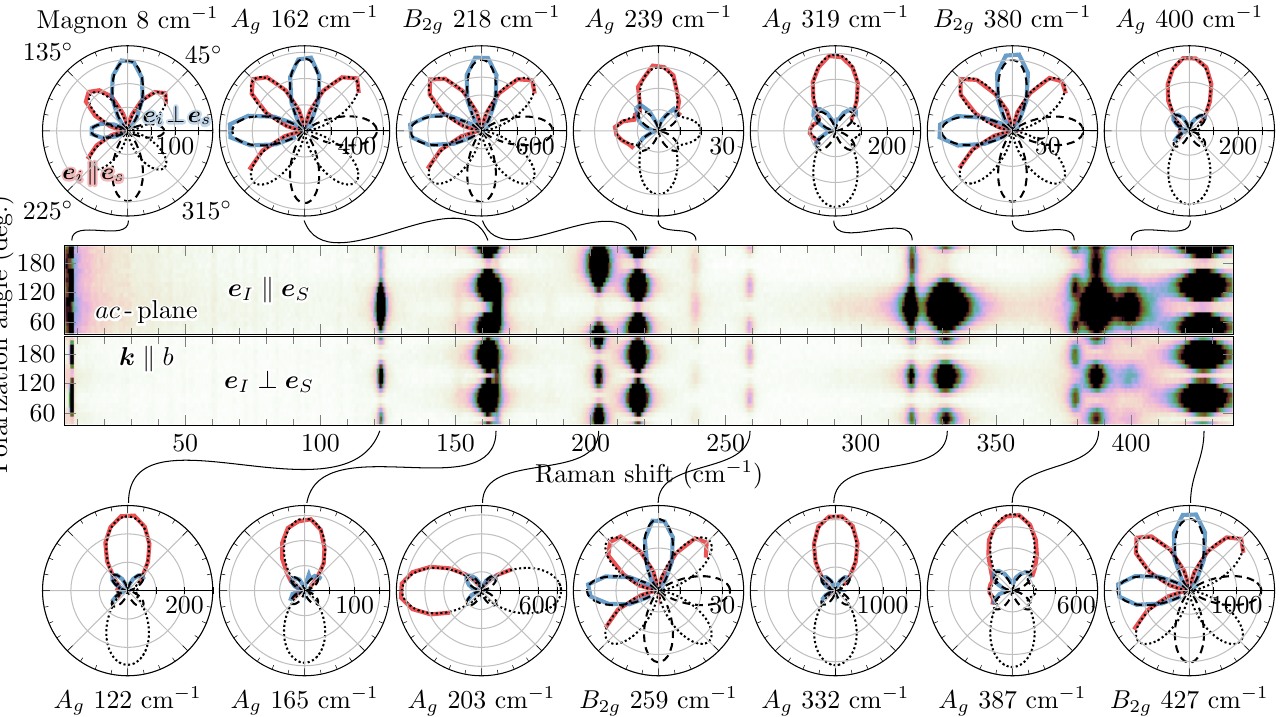
Figure 3. Raman scattering maps of the intensity, plotted as a function of the Raman shift and angle between the selected crystallographic axis and polarization plane defined by e I , measured on the ac plane of the Fe 3 BO 6 sample at room temperature, as shown in the middle. Polar dependencies of the integral intensities (magnitude (counts/s/mW)) are shown above and below. Red and blue e S ) and crossed ( e I e S ) polarization configurations. Black solid lines correspond to parallel ( e I (cid:107) ⊥ dotted and dashed curves are the results of model calculations (Equation (2)) for these configurations, respectively, and are used to extract the Raman tensor elements. Symmetry and the frequency of each mode are shown close to the relevant polar